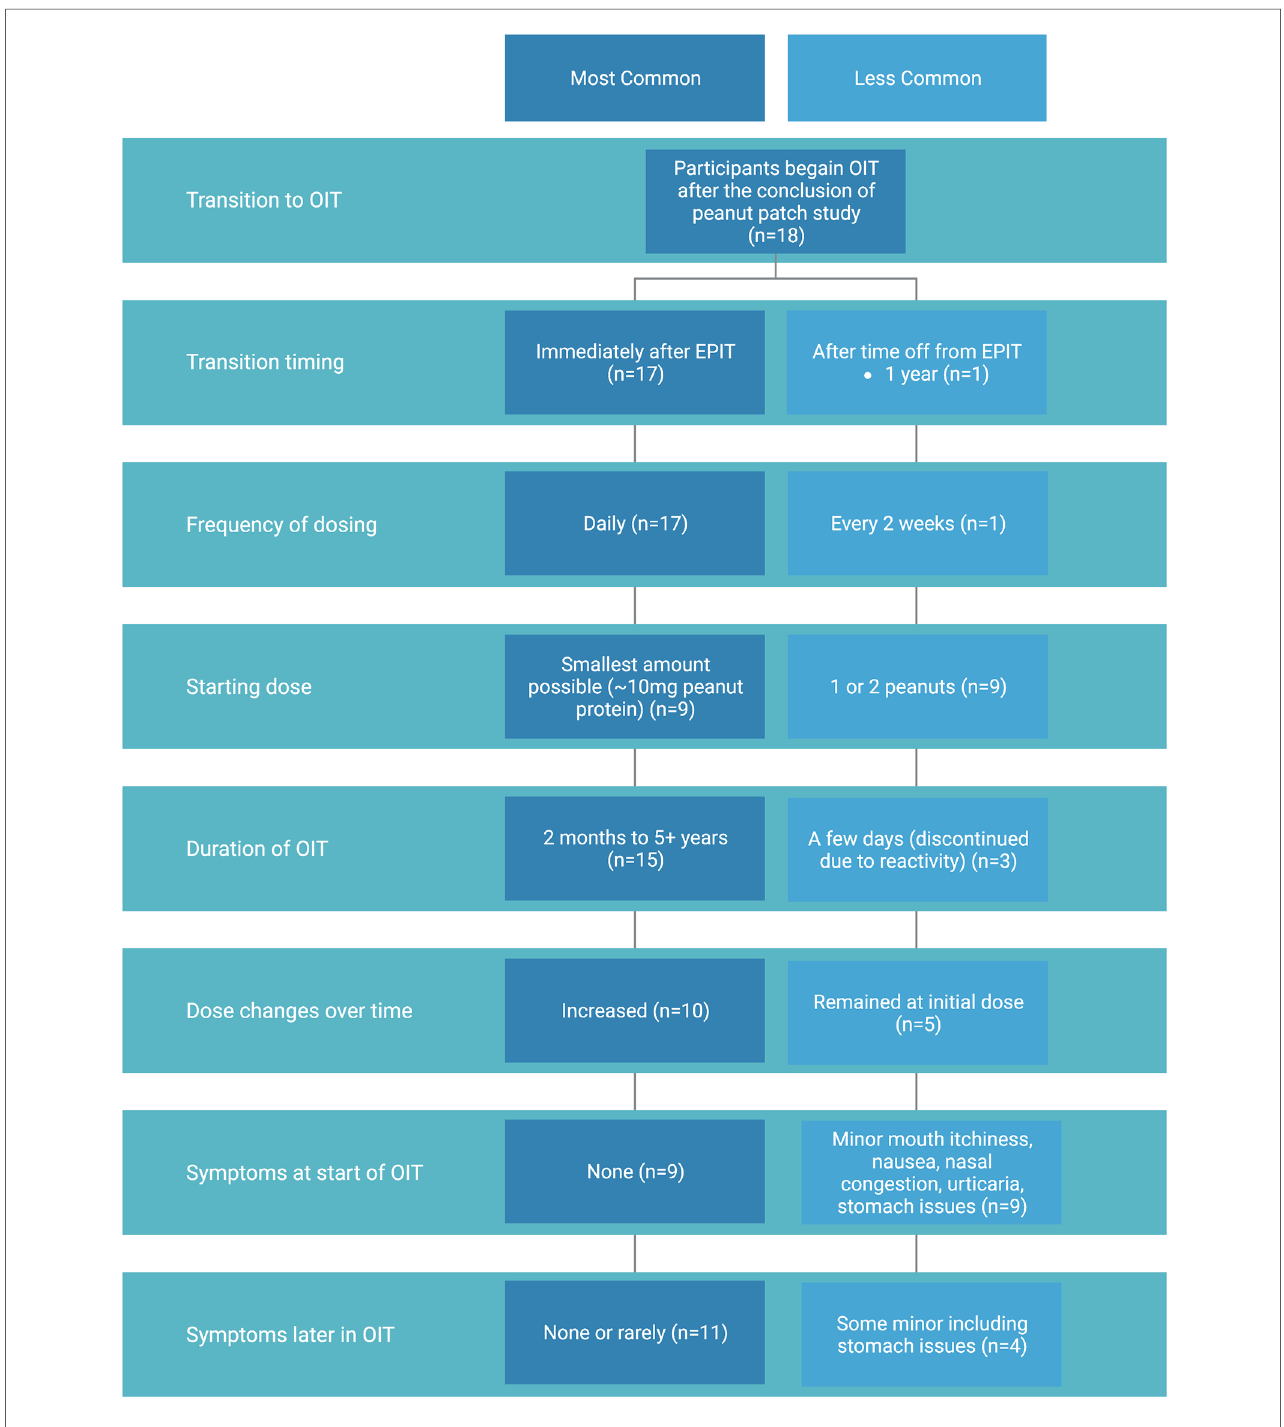
FIGURE 2 Summary of OIT experience of participants who transitioned from peanut patch to OIT including most common (dark blue) and less common (light blue) methods and